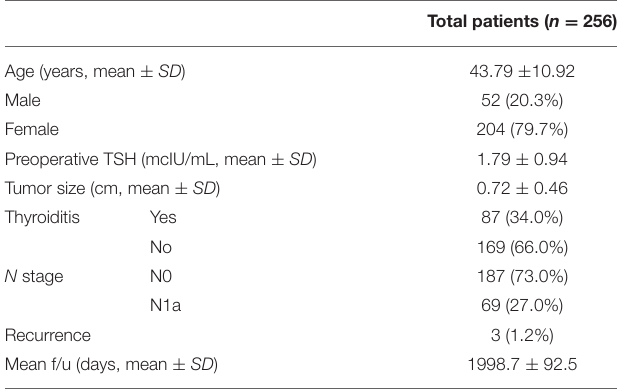
TABLE 1 | Baseline characteristics of the patients who underwent